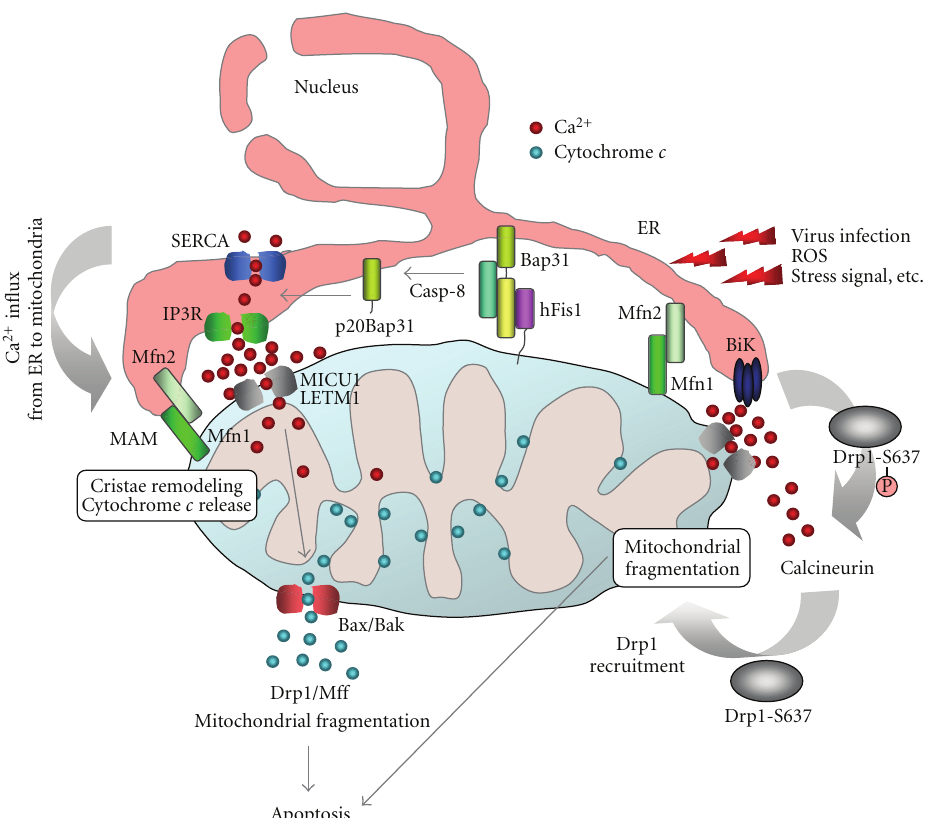
Figure 3: Hypothetical models of the role of contacts between mitochondria and ER in apoptosis. The hFis1/Bap31 platform transmits the mitochondrial stress signal to the ER via the activation of procaspase-8. The cytosolic region of the ER integral membrane protein Bap31 is cleaved by activated caspase-8 to generate proapoptotic p20Bap31, which causes rapid transmission of ER calcium signals to the mito- chondria via the IP3 receptor. At close ER-mitochondria contact sites, mitochondria takes up calcium into the matrix via the mitochondrial calcium channels MICU1 or LETM1. The massive influx of calcium leads to mitochondrial fission, cristae remodeling, and cytochrome c release. Mfn2 is enriched in the mitochondria-associated membranes (MAM) of the endoplasmic reticulum (ER), where it interacts with Mfn1 and Mfn2 on the mitochondria to form interorganellar bridges. Upon apoptosis signal, a BH3-only member of the Bcl-2 family, Bik, induces Ca 2+ release from the ER and, in turn, induces Drp1 recruitment to the mitochondria and their fragmentation and cristae remodeling. SERCA, sarco/endoplasmic reticulum Ca 2+ -ATPase. MICU1, mitochondrial calcium uptake 1. LETM1, leucine zipper/EF hand- containing transmembrane